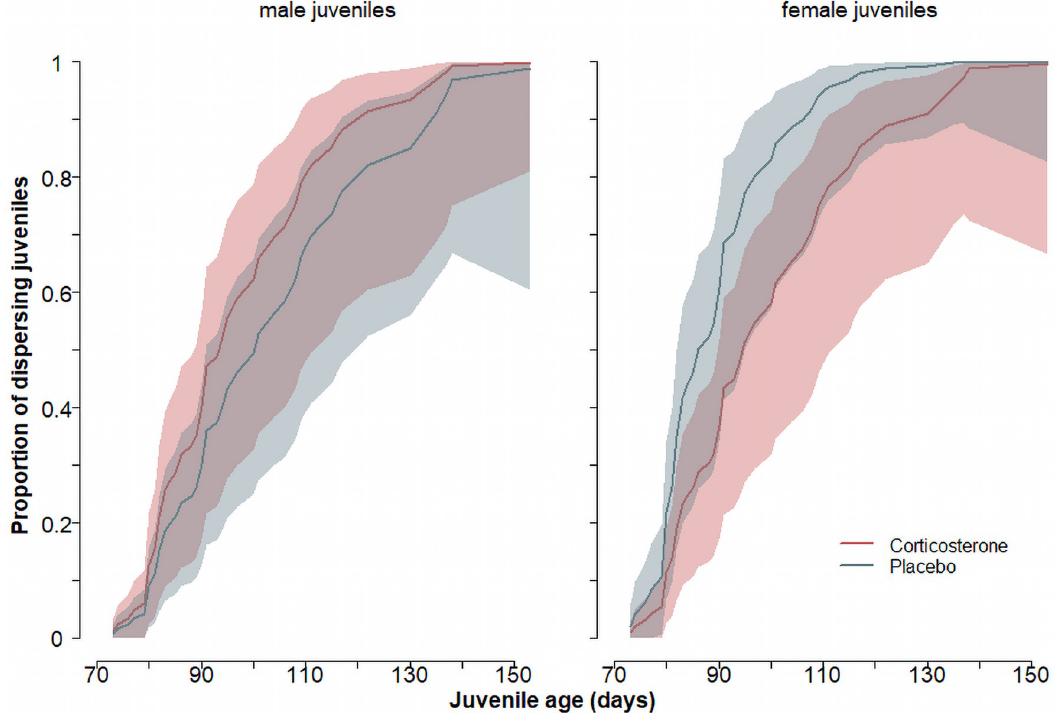
Fig 3. Proportion of juveniles (with 95% CrI) leaving the parental home range in relation to juvenile age based on a cox proportional hazard model. Left panel: male juveniles, right panel: female juveniles. Corticosterone- and placebo-implanted juveniles are in red and grey-green,